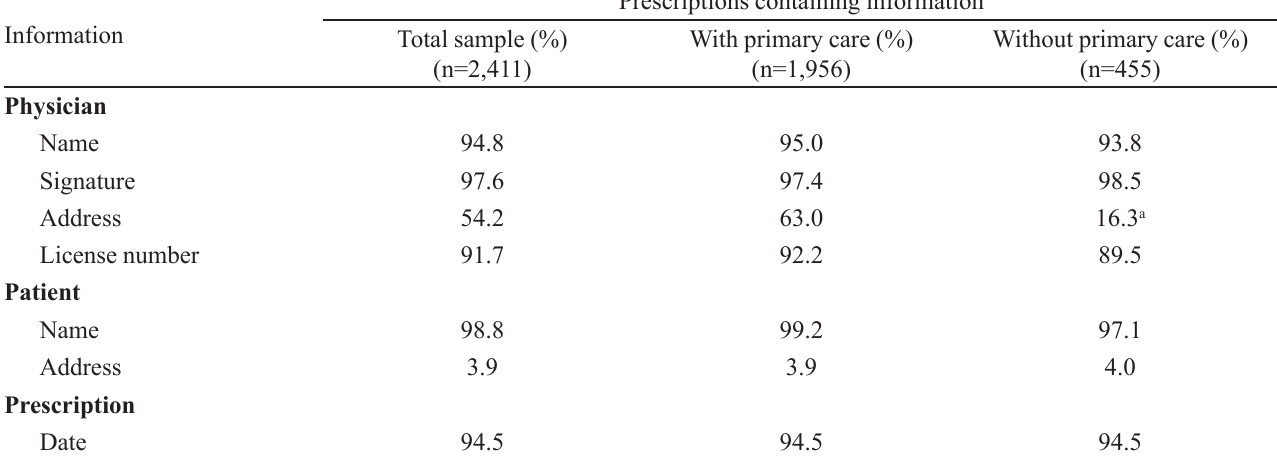
TABLE II - Legal aspects of the prescription – specific information on the prescribing physician and patient, as assessed in